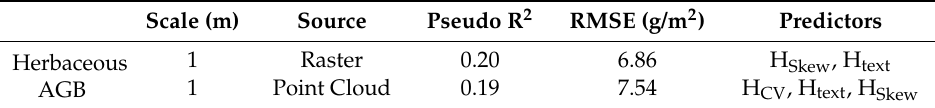
Table 5. Results of the RF regression for herbaceous biomass representing 1-ha plots.